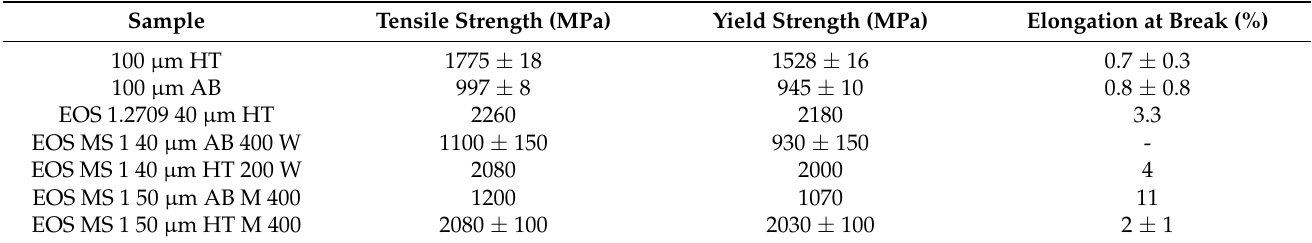
Table 14. Tensile test results and comparison with values declared by EOS.